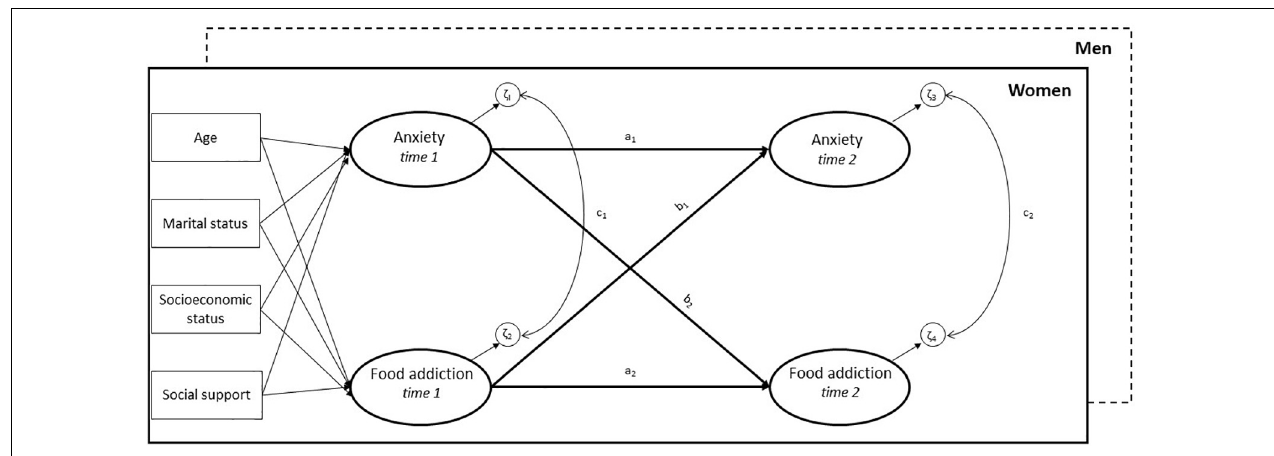
FIGURE 1 | Multiple-group latent autoregressive cross-lagged panel model of the association between anxiety and food addiction. a 1 , a 2 : autoregressive paths, b 1 , b 2 : cross-lagged paths; c 1 , c 2 : cross-sectional paths. The measurement models for the latent variables with pairwise correlated errors over time are not shown. Model adjusted for age, marital status, socioeconomic status and social support at time 1.